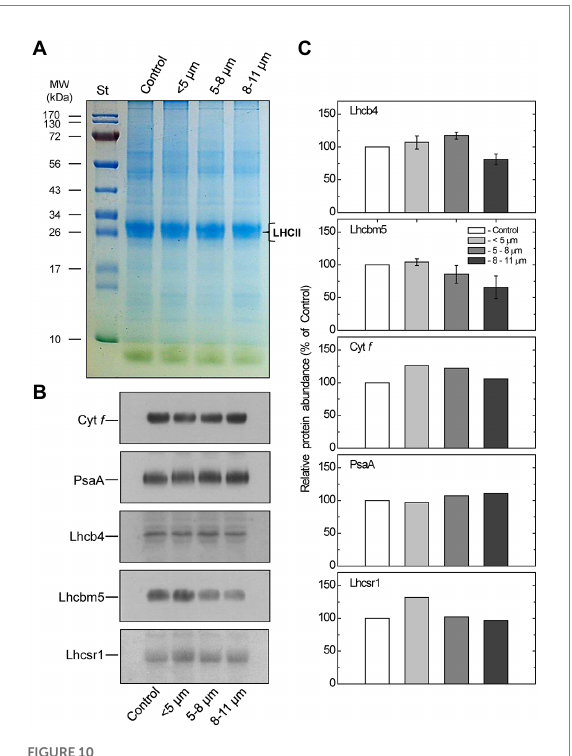
FIGURE 10 Coomassie stained SDS-PAGE analysis of thylakoid membrane proteins from control and different-sized cell fractions of C. priscuii (A) . Lanes of SDS-PAGE were loaded on an equal Chl basis. Values on the left indicate apparent molecular mass (kDa). B – Representative Western blots (B) and densitometric analysis (C) of polypeptides probed with antibodies raised against Cyt f, Lhcbm5, Lhcb4, and PsaA polypeptides in thylakoid membranes isolated from different-sized cell fractions of C. priscuii . Mean values ± SE were calculated from 3 independent experiments. The presented data were normalized to the relative abundance of the respective polypeptides in the control whole cell